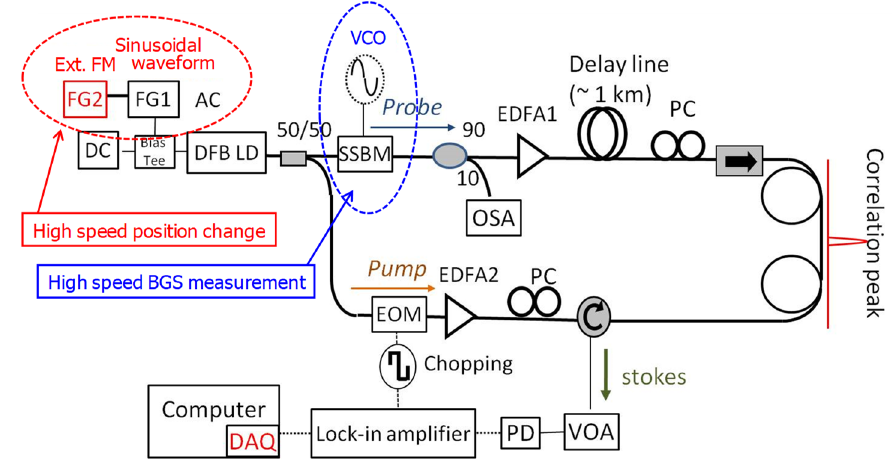
Figure 29. BOCDA system to realize a fast random accessibility speed [67].